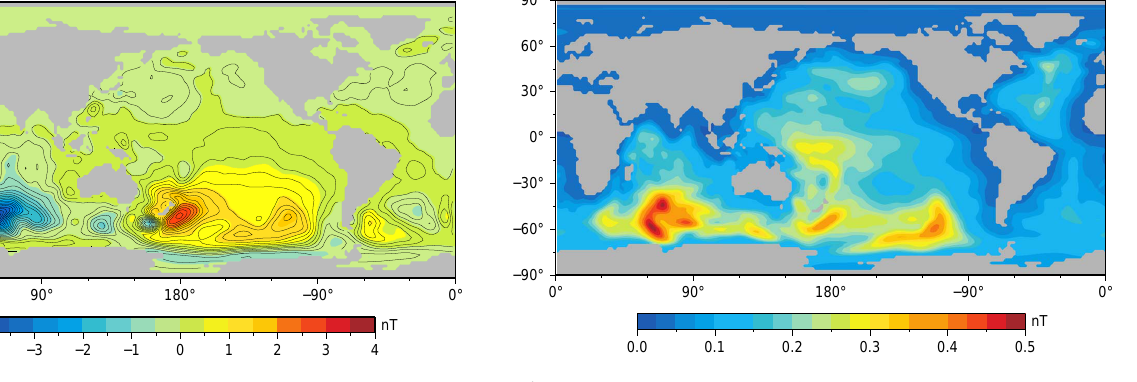
Figure 3. Annual mean values of motionally induced magnetic field at sea level altitude due to ocean global circulation from the constant conductivity experiment in nanoteslas (nT).